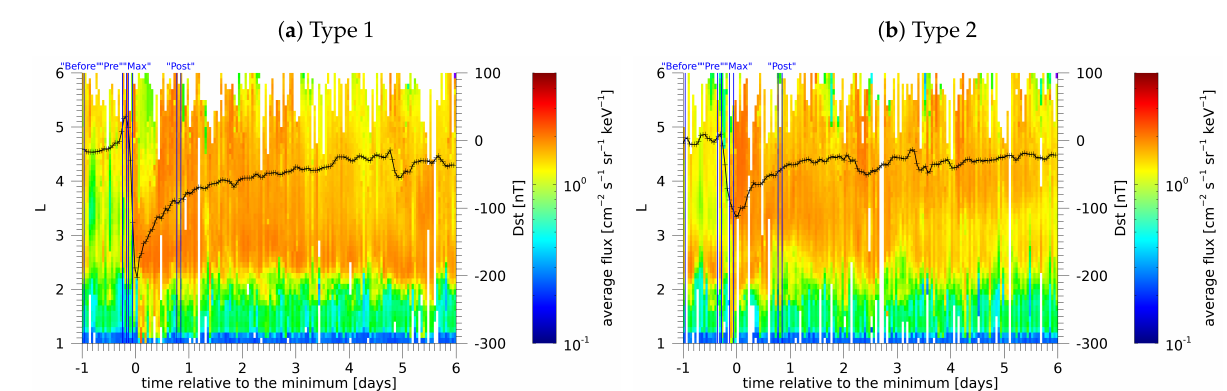
Figure 3. The same as Figure 2 but separated according to ( a ) Type 1 storms and ( b ) Type 2 storms.